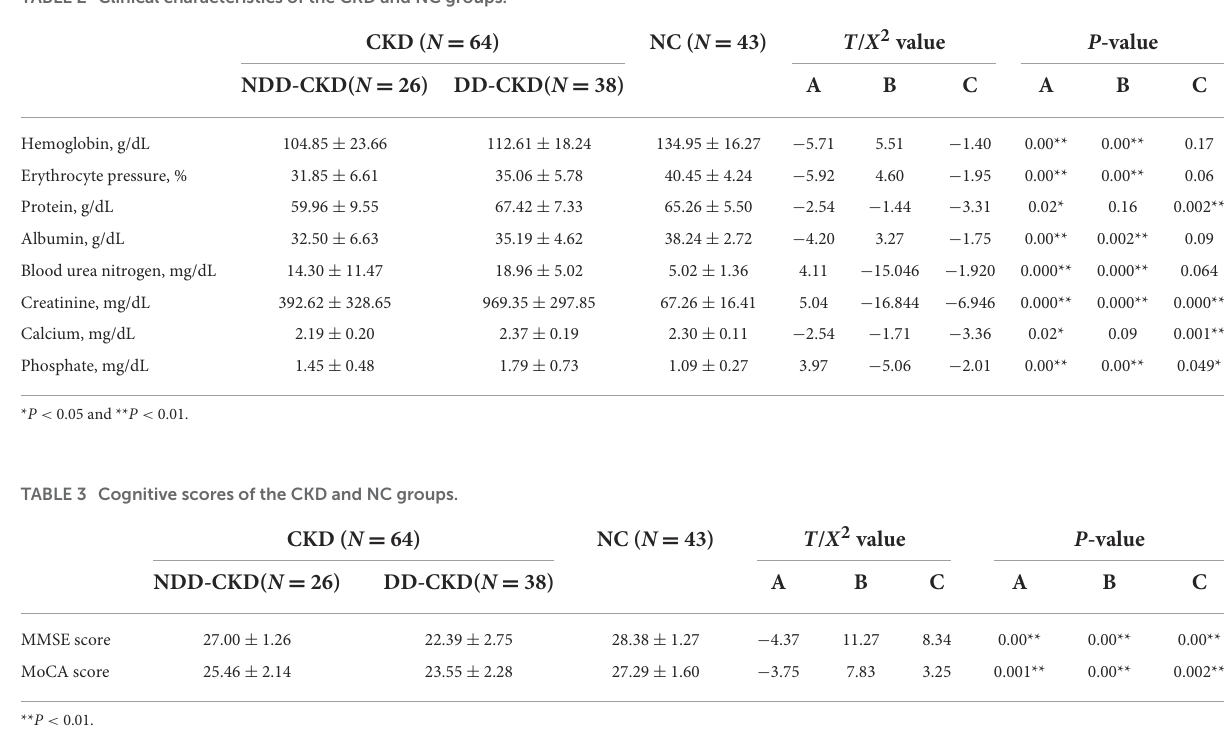
TABLE 2 Clinical characteristics of the CKD and NC groups.